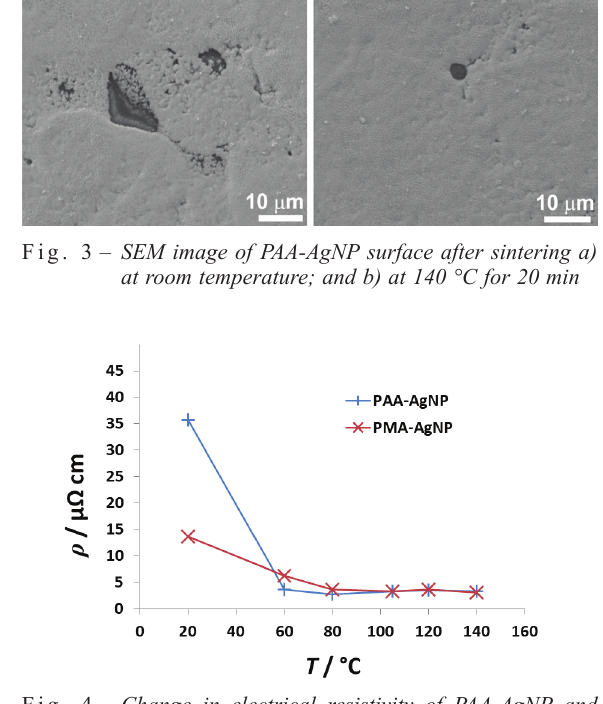
Fig. 4 – Change in electrical resistivity of PAA-AgNP and PMA-AgNP printed silver features, after thermal sintering at different temperatures for 20